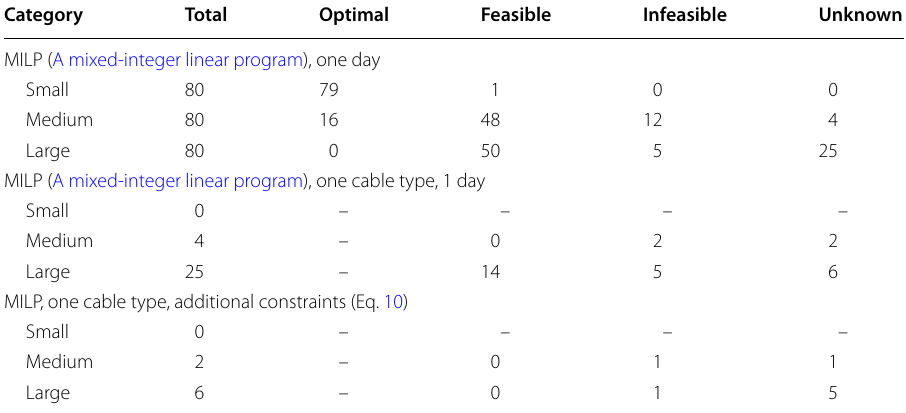
The specifications for the experiments are in the main text body